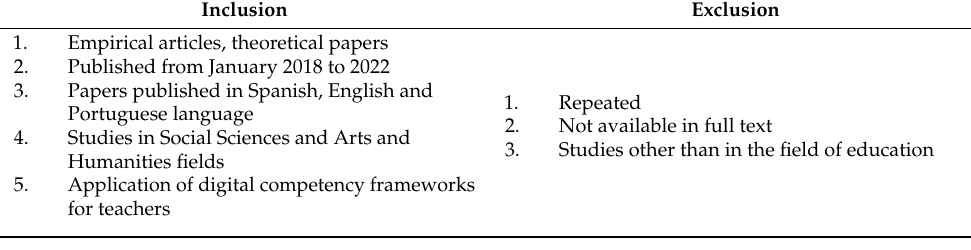
Table 2. Inclusion and exclusion criteria for the review .